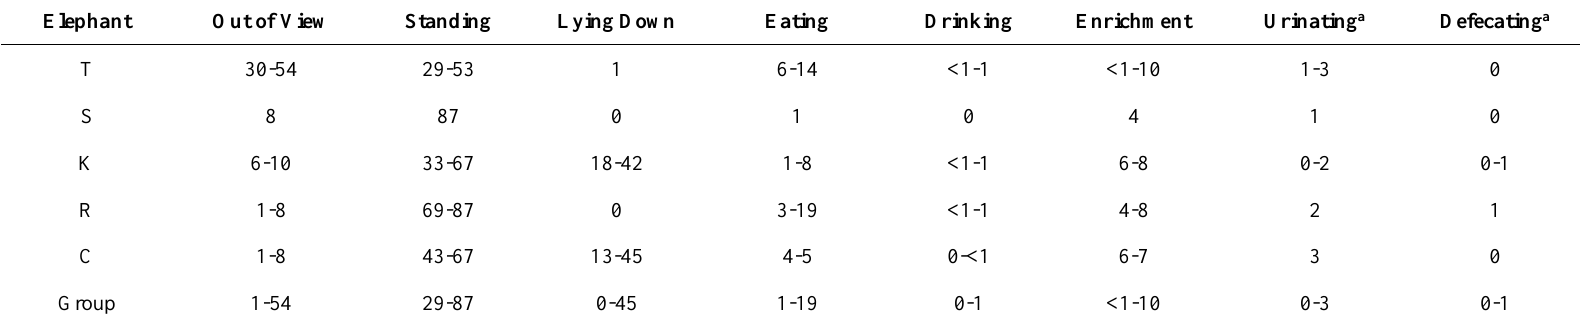
Range of Percentages of Nocturnal Observation Period Spent in Each Mutually Exclusive Behaviour, for Each Elephant and the Group Elephant Out of View Standing Lying Down